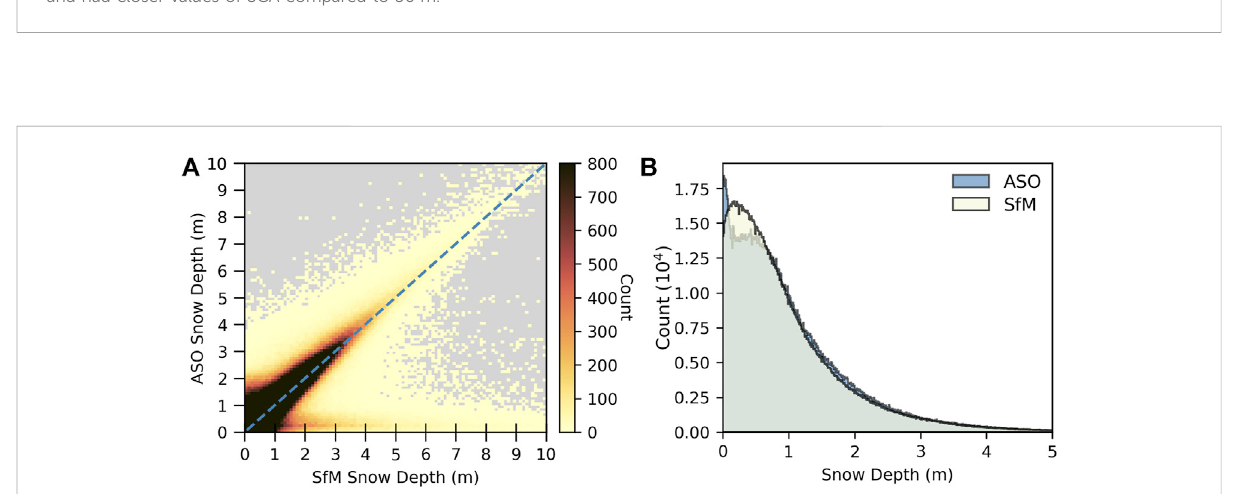
FIGURE 5 SfM snow depth values plotted against ASO snow depth values at the 3 m resolution in the coinciding area (A) . The dashed line shows a hypothetical one-to-one relationship. SfM tended to underestimate the snow depth compared to ASO at the same pixel locations. The snow depth histograms showed a strong agreement between the ASO (blue) and SfM (beige), in the overlapping areas with measured depth (B)